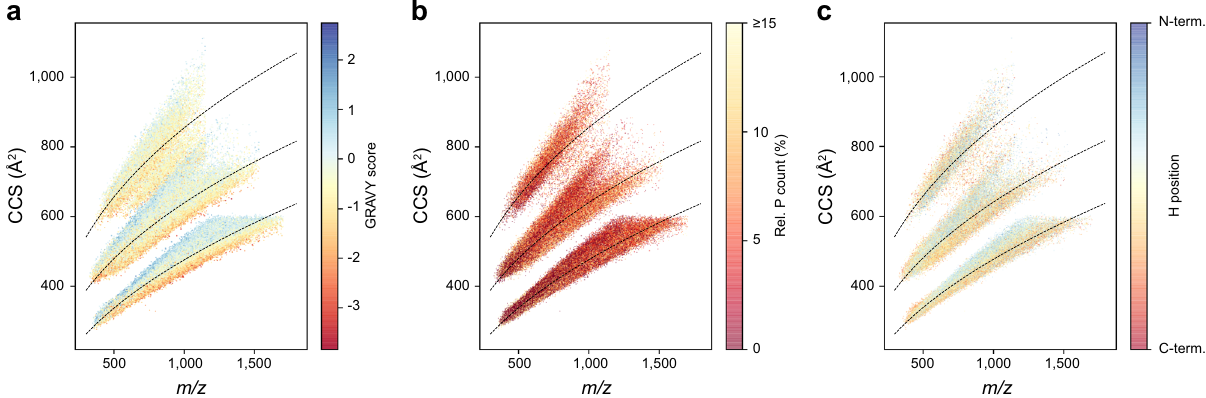
Fig. 3 A global view on peptide cross sections. a Mass-to-charge vs. collisional cross section distribution of all peptides in this study colored by the GRAVY hydrophobicity index ( n = 559,979). b Subset of peptides with C-terminal arginine or lysine colored by the fraction of prolines in the linear sequence ( n = 452,592). c Histidine-containing peptides of ( b ) colored by the relative position of histidine ( n = 171,429). Trend lines (dashed) are fi tted to the overall peptide distribution to visualize the correlation of ion mass and mobility in each